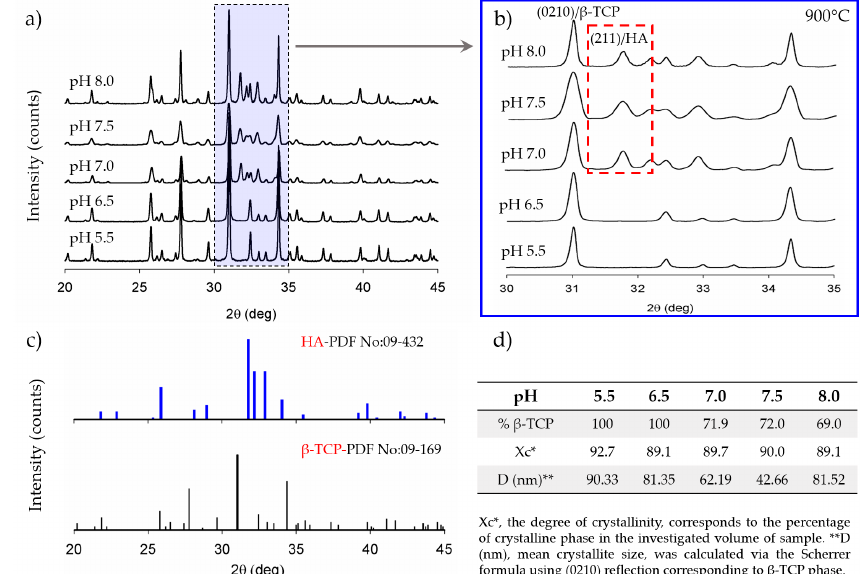
Figure 4. XRD investigation of the samples that were sintered at 900 ◦ C: ( a ) For the range of 20–45 ◦ ; ( b ) for the range of 30–35 ◦ ; ( c ) XRD spectra of standard HA (No:09-0432) and β -TCP (No: 09-0169); ( d ) calculated percentage of transformed β -TCP, average crystallite size, and the degree of crystallinity. The transformation from CDHA to β -TCP was completed for the samples that were synthesized under pH 5.5 and pH 6.5.